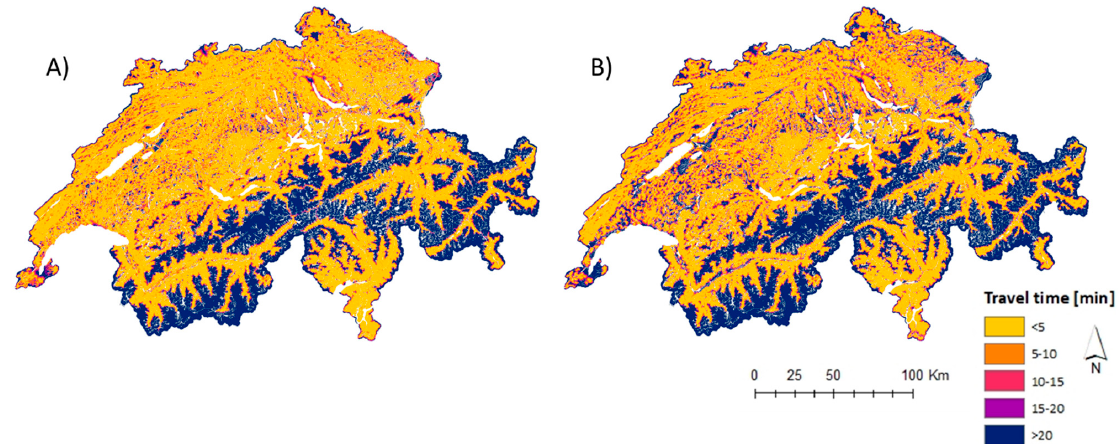
Figure 4. Travel times to reach forest patches ( A ) with a walk and motorized travel scenario, and ( B ) with a walking-only scenario.